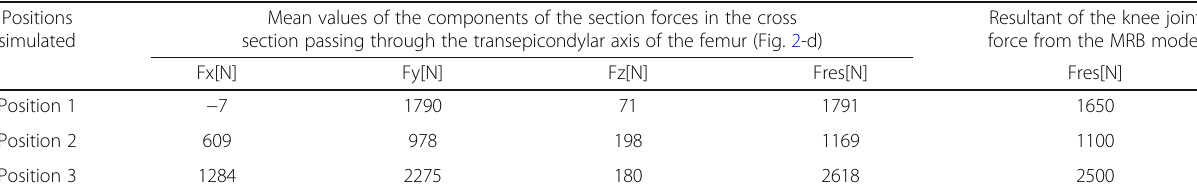
Table 3 Comparison of the knee joint force in the MRB model with the section forces in the cross section passing through the transepicondylar axis of the femur (Fig. 2-d). The forces were given in the coordinate system of Fig. 3-b. Fx, Fy, Fz were the components of the Force; Mx, My, Mz were the components of the Moment. Fres and Mres were the resulting of the force and of the moment respectively Positions Mean values of the components of the section forces in the cross simulated section passing through the transepicondylar axis of the femur (Fig. 2-d)